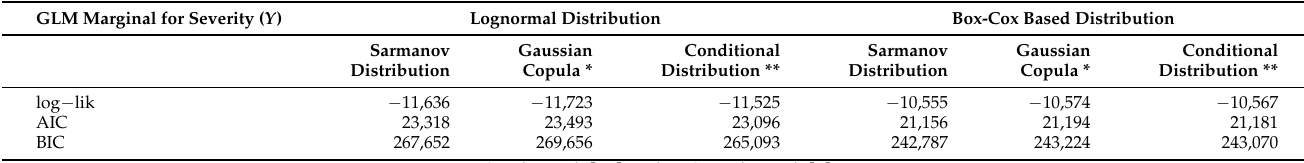
Table A1. Log-likelihood, AIC and BIC for alternative multivariate models with a NB GLM marginal for frequency variable ( N